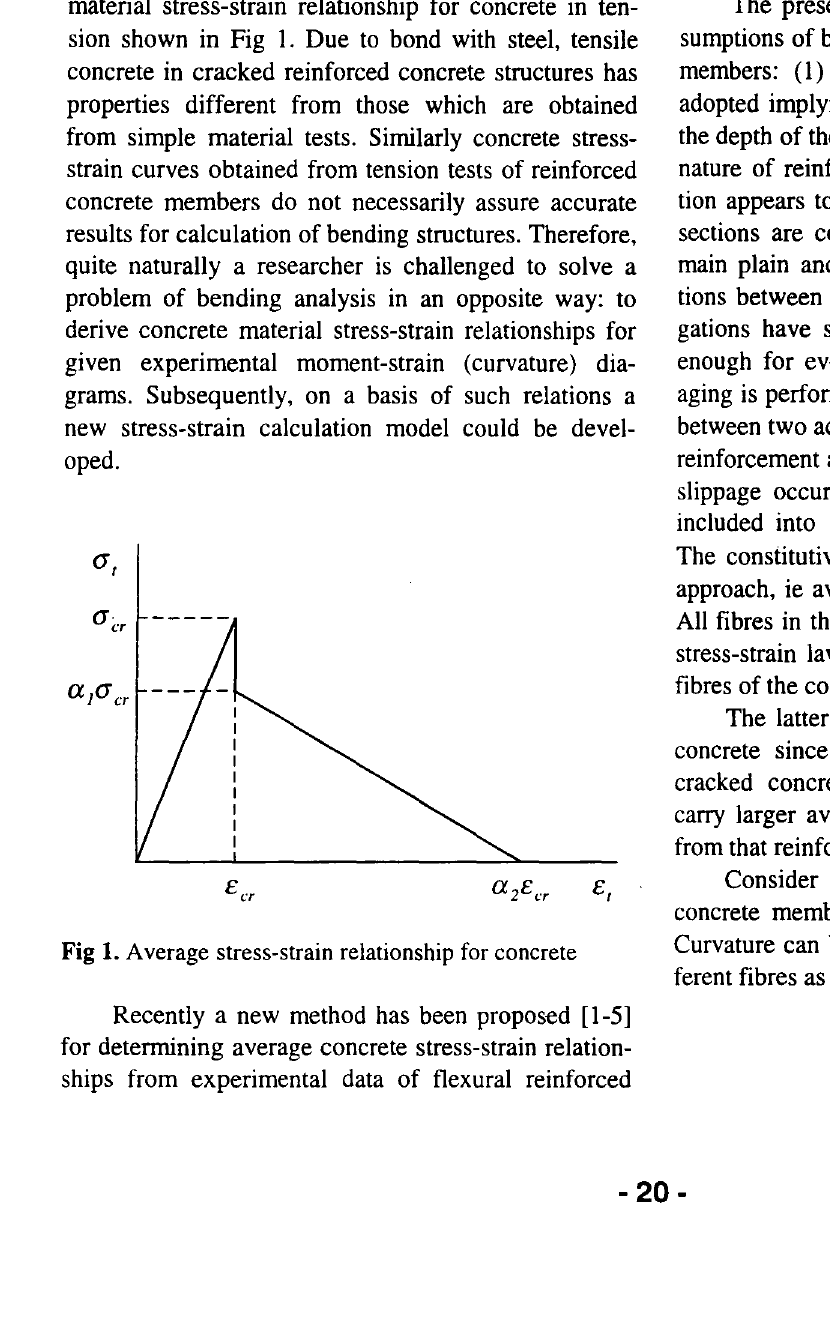
Fig 1. Average stress-strain relationship for